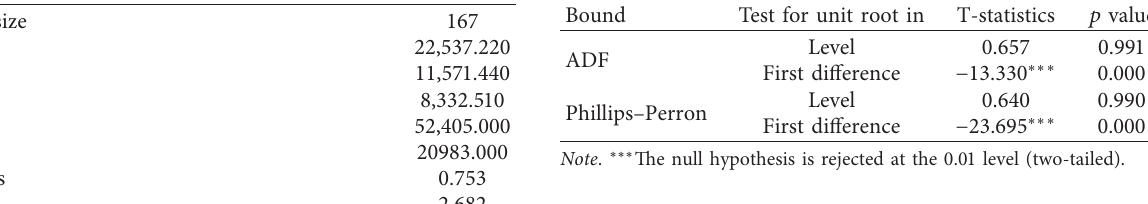
Table 1: Statistical description of the housing price series.